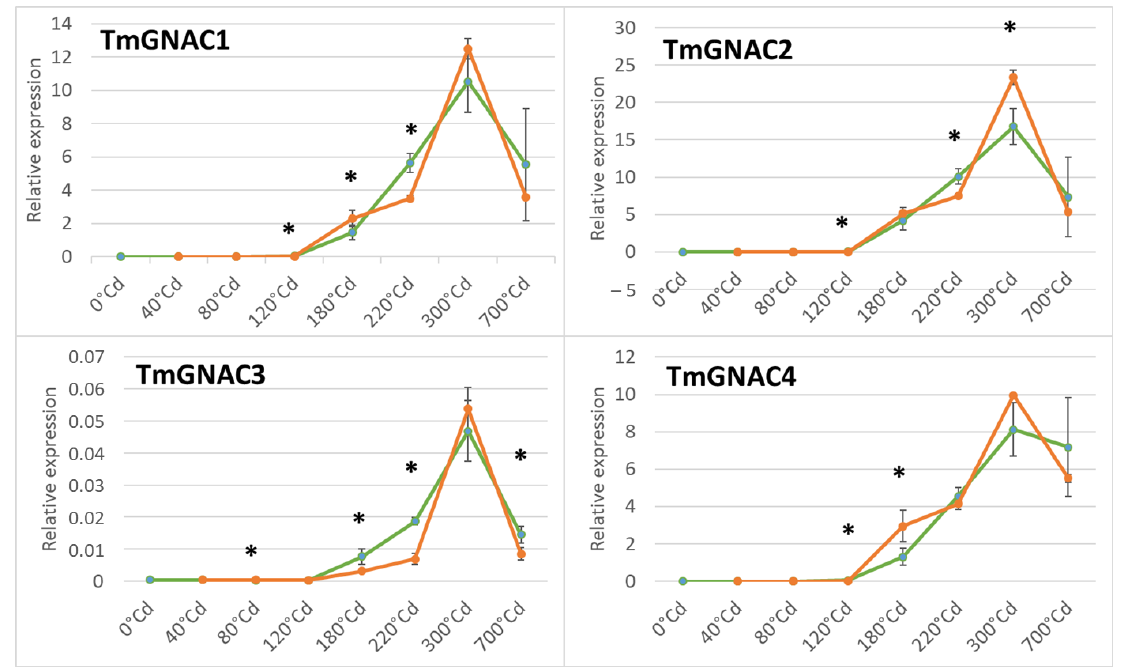
Figure 4. Expression profile of the TmGNAC1 , TmGNAC2 , TmGNAC3 , and TmGNAC4 genes in einkorn grain during eight developmental stages. The expression was monitored in control (19 °C, green curve) and moderate thermal stressed condition (27 °C during 10 days after anthesis, orange curve). * = significant difference between control and stressed conditions ( T test, p -value < 0.05). The significant difference observed at 120 °Cd after anthesis for the TmGNAC1 , TmGNAC2 and TmGNAC4 reveals a higher expression in the control condition compared to the stressed condition.